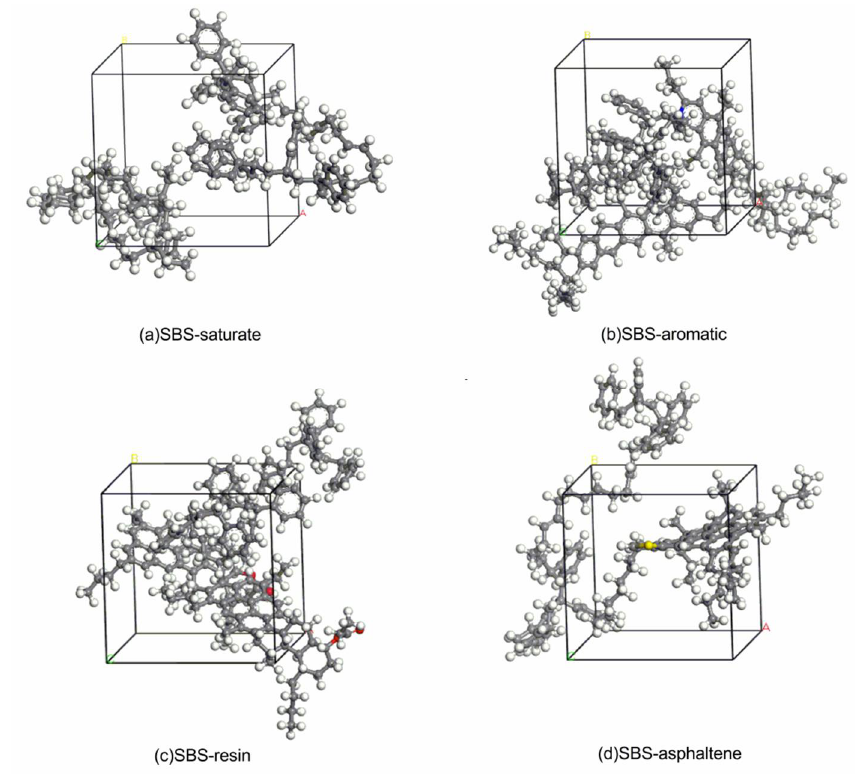
Figure 2. Four system models after energy minimization: ( a ) SBS–saturate; ( b ) SBS–aromatic; ( c ) SBS–resin; ( d ) SBS–asphaltene.